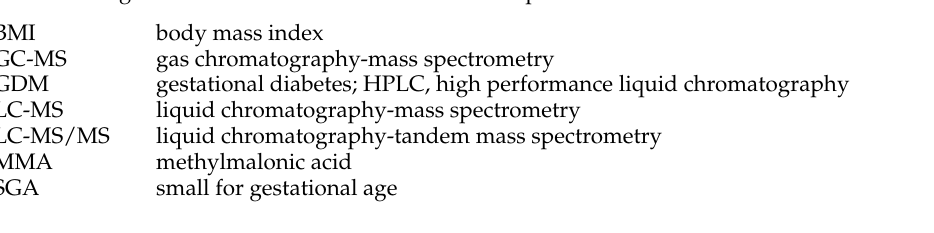
Figure S1: Correlation between serum methylmalonic acid and homocysteine levels in pregnant Korean women. Serum methylmalonic acid and homocysteine levels showed a weak positive correlation ( ρ = 0.3346, p < 0.0001). The circles denote results of serum methylmalonic acid and homocysteine levels. The filled circle denotes results of a pregnant woman whose serum vitamin B12 < 200 pg/mL, Table S1: Association between basic demographic characteristics and maternal and neonatal outcomes in pregnant Korean women ( p -values for univariate analysis), Table S2: Vitamin B12 deficiency in 62 pregnant Korean women based on serum methylmalonic acid, homocysteine, and vitamin B12 concentrations using cutoffs reported in